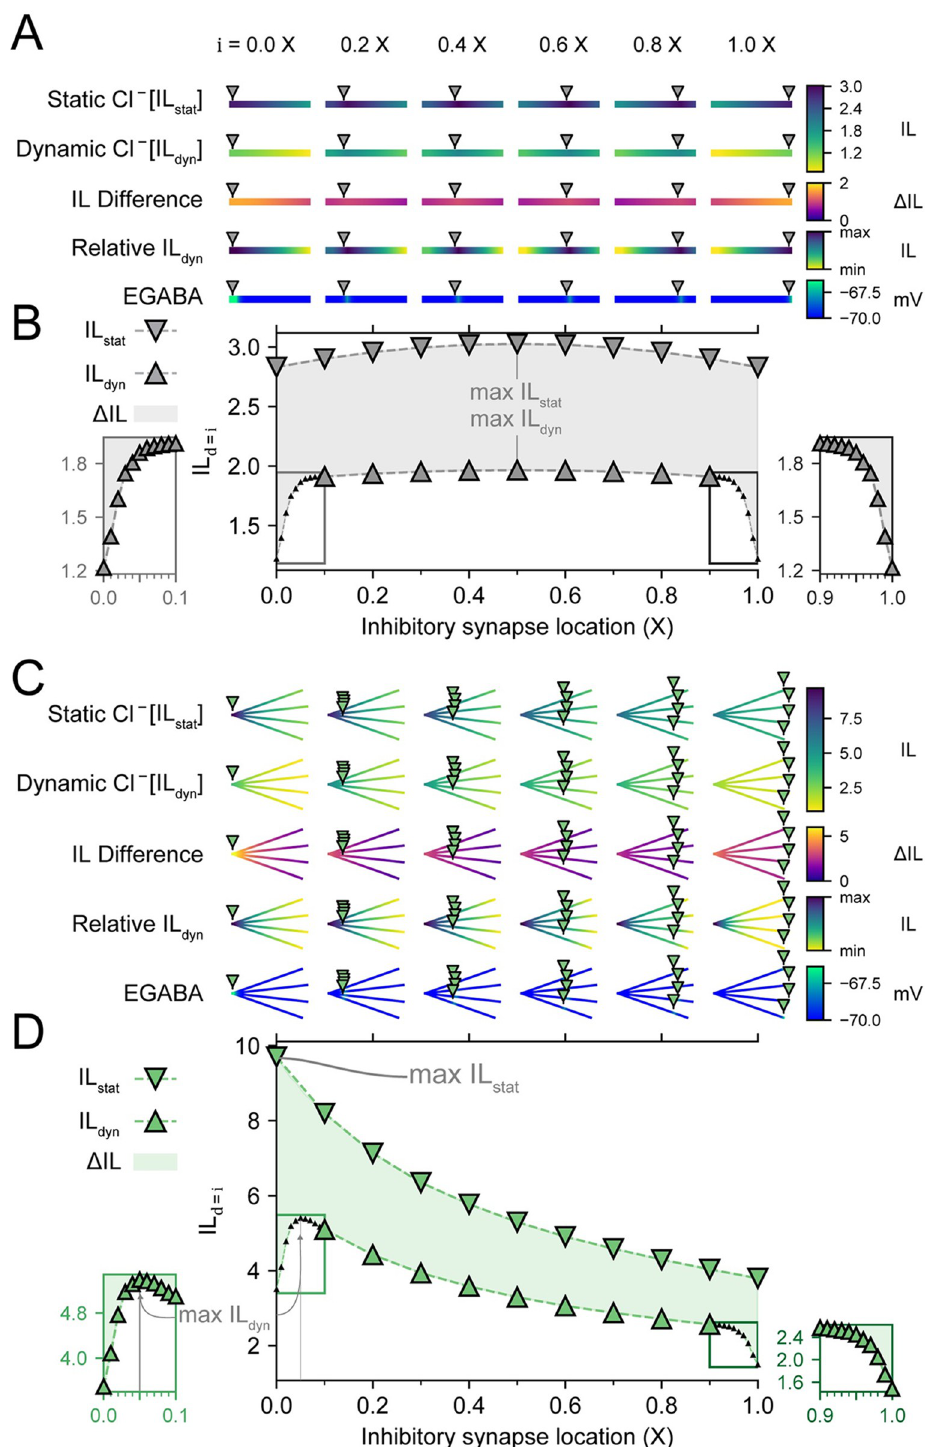
Fig 6. Dynamic chloride has a differential effect on Inhibitory Level depending on the location of inhibitory synaptic input. (A) Heatmaps of a single-branched dendrite indicate how IL with static Cl - (IL stat ) and IL with dynamic Cl - (IL dyn ), the difference between these ( Δ IL) are differentially affected by inhibitory synapse location (0.0, 0.2, 0.4, 0.6, 0.8, 1.0 X). In addition to heatmaps with values shared across synapse location, the relative IL heatmaps are independent of each other and indicate the IL throughout a dendrite scaled to that dendrite’s minimum and